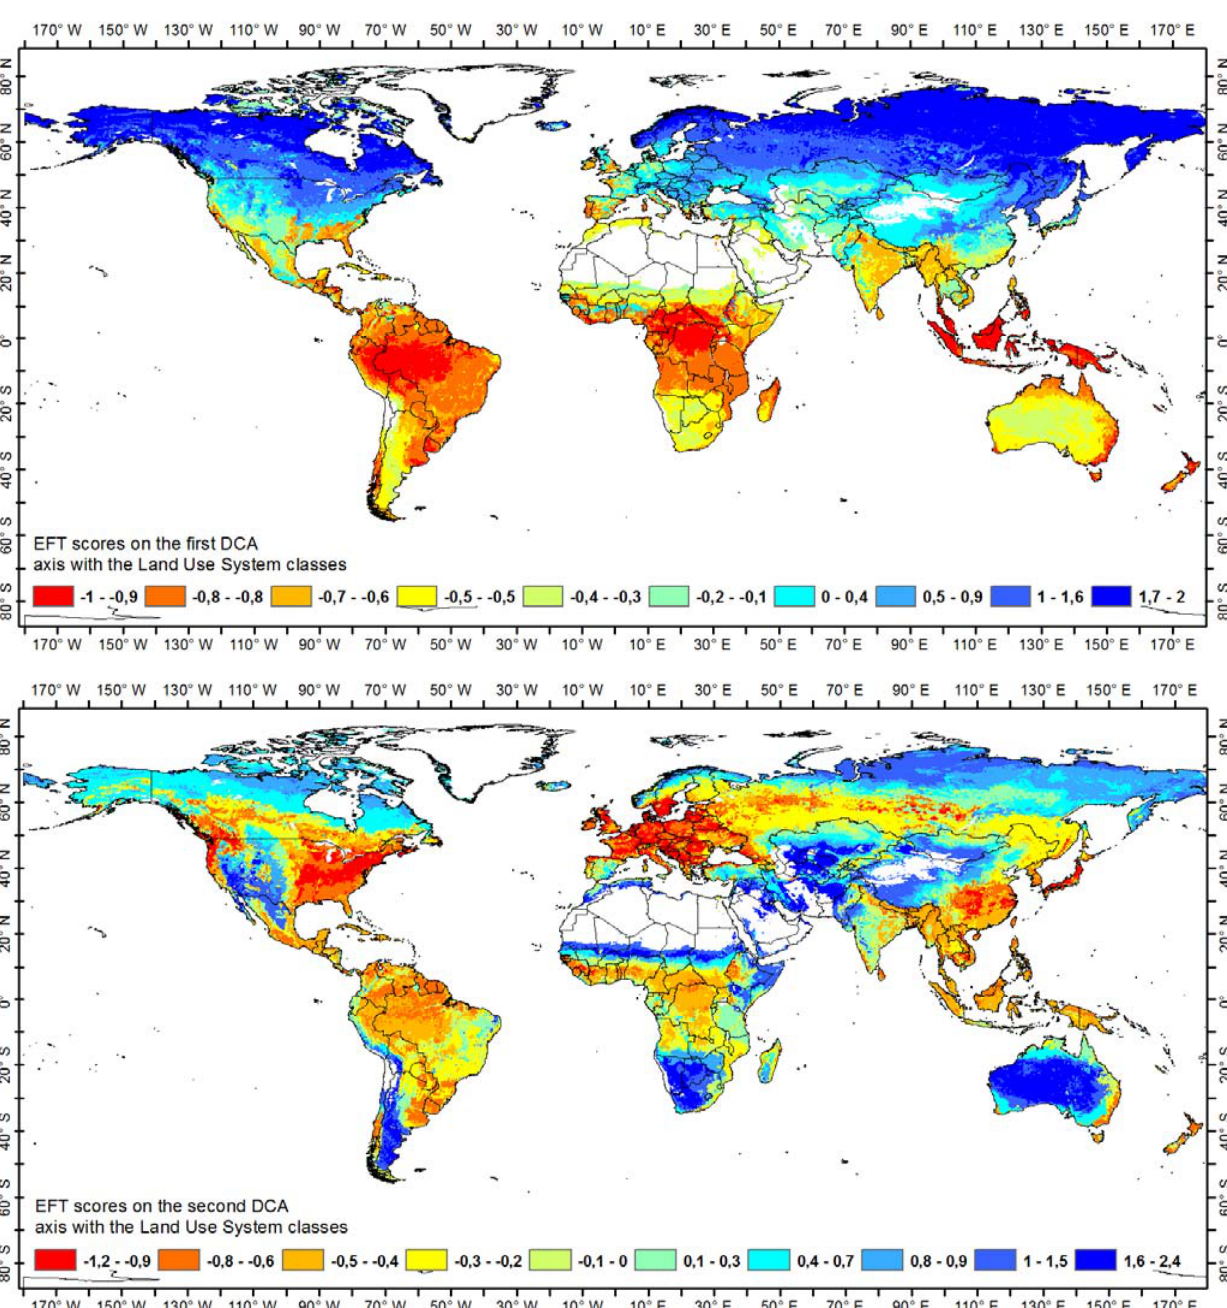
Figure 10. Spatial patterns of the first ( top ) and second ( bottom ) axis derived from DCA of the EFTs with the Land Use System classes. White areas represent pixels without vegetation